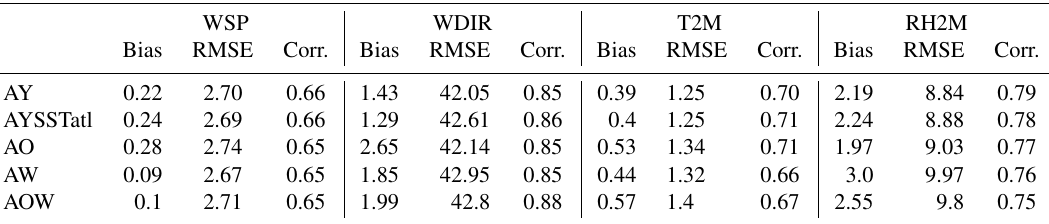
Table 3. Scores against observations from moored buoys and surface weather stations for the 10m wind speed (WSP, ms − 1 ), the 10m wind direction (WDIR, ◦ ), the air temperature at 2m (T2M ◦ C) and the relative humidity at 2m (RH2M,